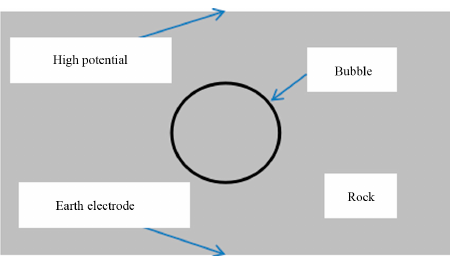
Figure 7. Simple model of bubbles in rocks.